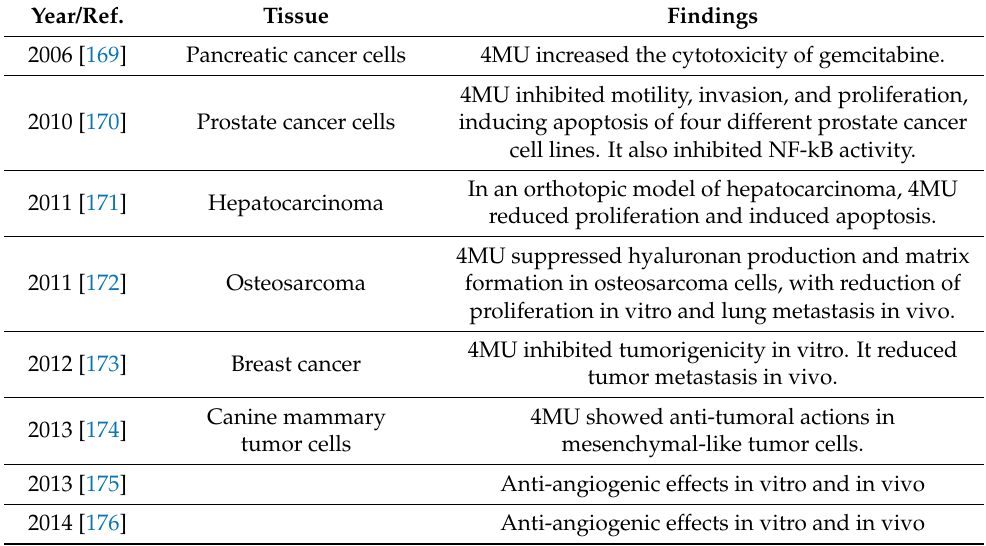
Table 4. Evidence of 4MU’s anti-tumoral